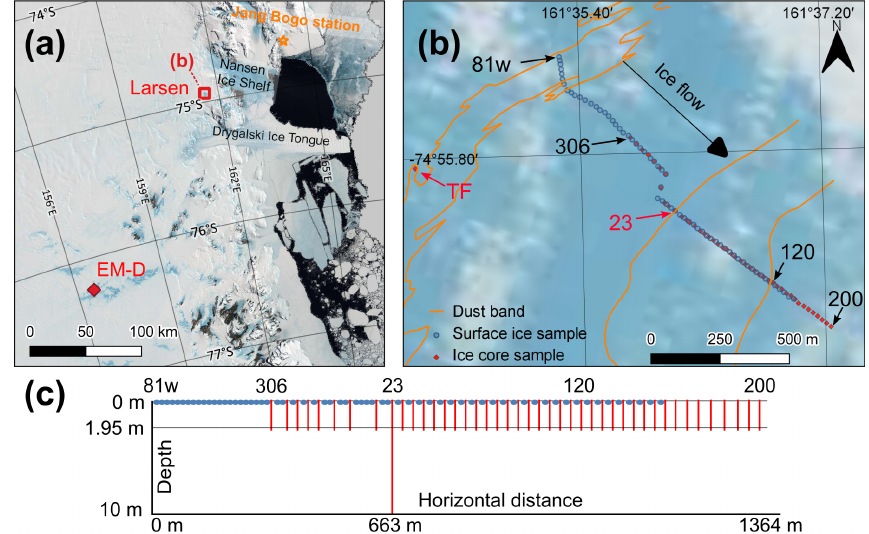
Figure 2. Location of the Larsen BIA and sample collection. (a) Location of the Larsen BIA, EM-D (Elephant Moraine) core, and Jang Bogo Station. (b) Magnified map of the Larsen BIA, including sample locations. Orange lines represent dust bands observed in the blue-ice field. The line marks are derived from Google Earth imagery (https://earth.google.com/web/@-74.93,161.58,1080.8673325a,2487.72294087d,49. 37163057y,347.89929343h,0t,0r, last access: 2 May 2022). Blue dots represent locations of surface ice samples. Red diamonds are locations of shallow ice cores. Six representative names are shown: red letters are for ∼ 10m long cores (TF and no. 23), and black letters are for 2m long cores (no. 306, no. 120, and no. 200) and surface ice (81w). Z and S folds are identified by the dust bands at upstream sites. The total length of the ice sample transect is approximately 1.4km. (c) Schematized cross-section of the transect. Satellite photo of Antarctica is from the QGIS Quantarctica package (Bindschadler et al.,